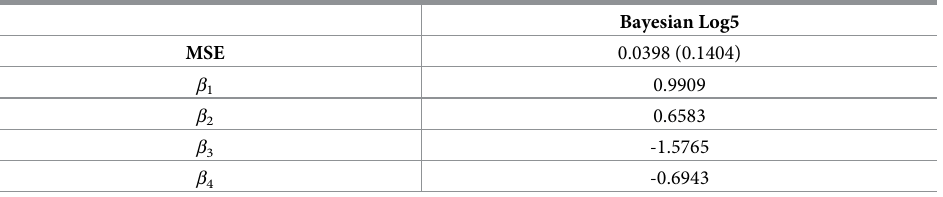
Table 6. MSE and the estimated coefficients of the four-variable Bayesian hierarchical log5 model using the coeffi- cients from the generalized log5 model as a hyperprior mean for β